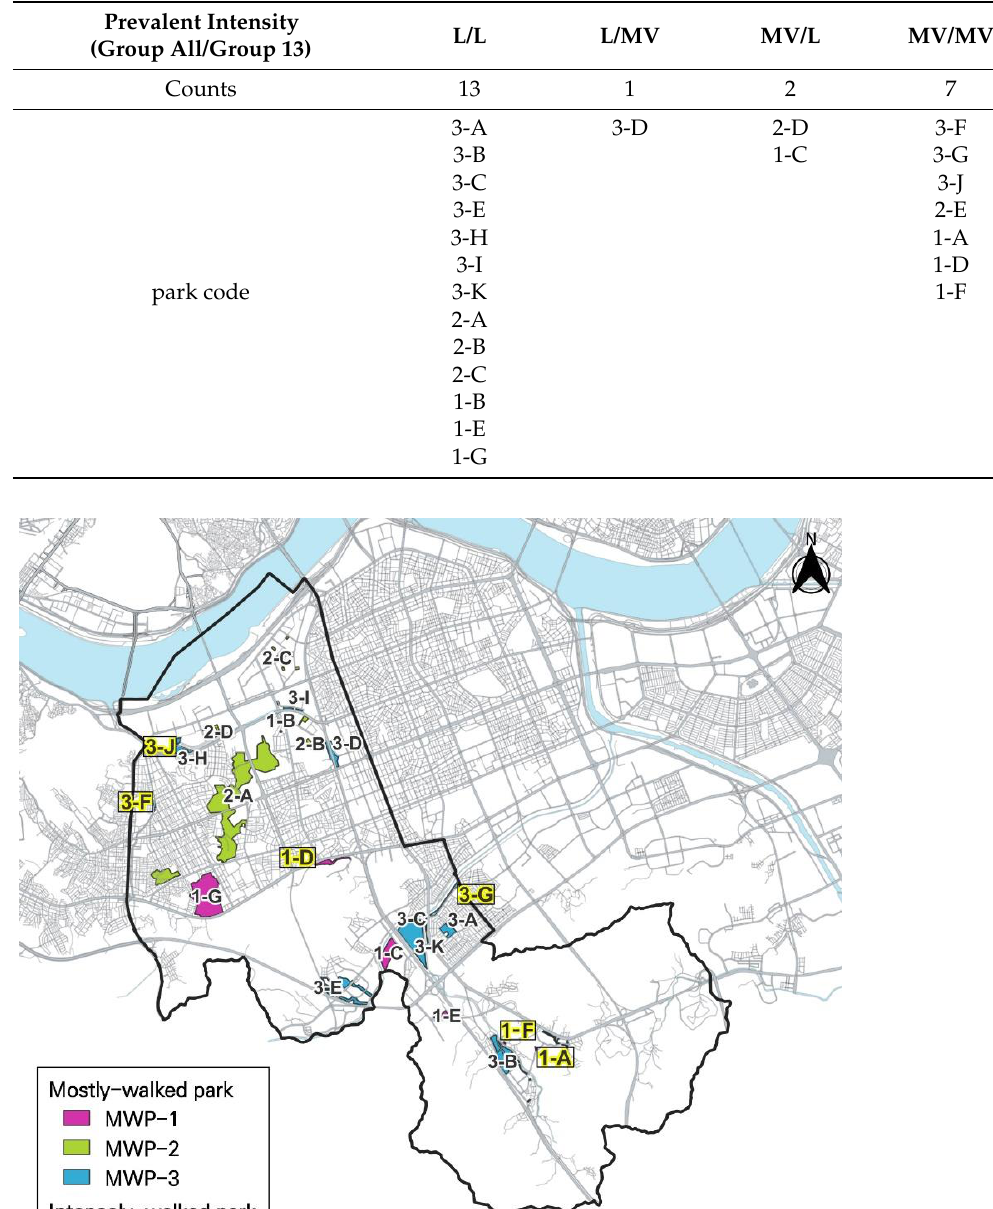
Table 8. Parks grouped by the prevalent intensity of Group All and Group 13.